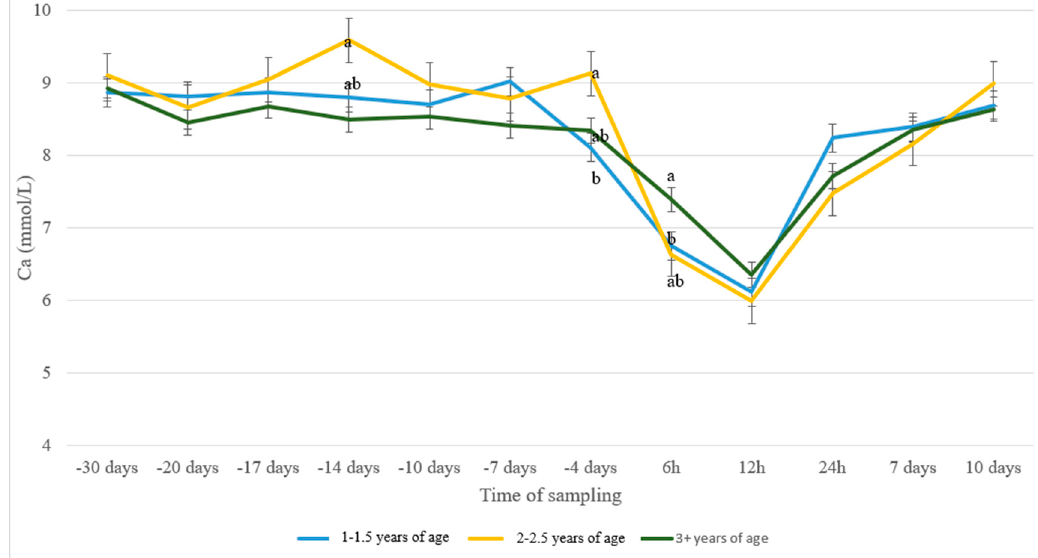
Figure 2. Ca levels (mmol/L) in blood serum of sheep in age groups 1–1.5 ( n = 35), 2–2.5 ( n = 11) and 3+ ( n = 41) years old during the peri-parturient period. a,b Different letters denote significant differences between groups within evaluation time ( p < 0.05).